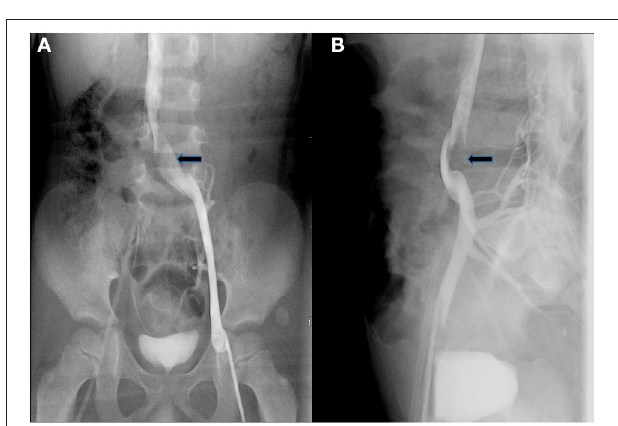
FIGURE 3 | Anteroposterior (A) and lateral (B) angiography showed that the anterior end of the narrow left common iliac vein was dilated and had filling defect (black arrows).